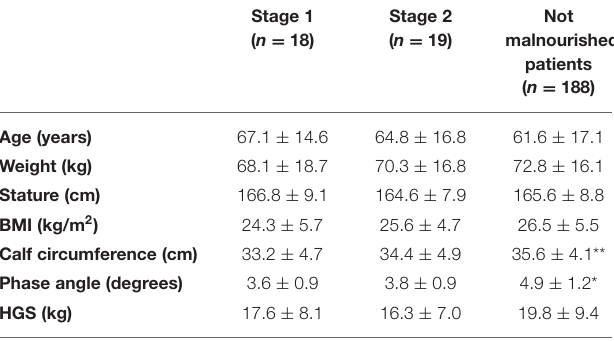
TABLE 2 | Anthropometric characteristics, handgrip strength and body composition according to the GLIM criteria (stage 1 = moderate malnutrition; stage 2 = severe